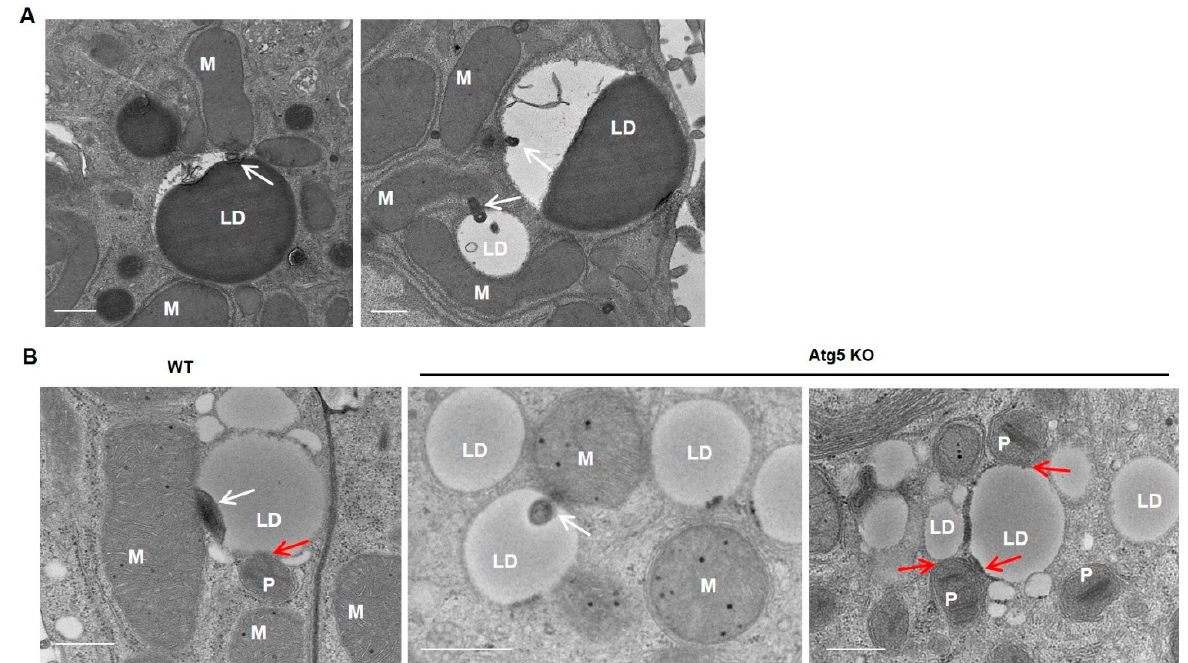
Figure 5. Dot- or tubular-like mitochondria–LD contact sites in starved or oleic-acid-treated primary mouse hepatocytes. Primary mouse hepatocytes were cultured in EBSS for 2 h followed by EM analysis. ( A ) Representative EM images from hepatocytes cultured in EBSS are shown. Hepatocytes isolated from liver-specific Atg5 knockout (KO) mice and the matched wild-type (WT) mice were treated with oleic acid (OA, 500 µM) for 6 h followed by EM analysis. ( B ) Representative EM images from OA-treated WT hepatocytes and Atg5 KO hepatocytes are shown. White arrows denote electron-dense dot- and tubular-like mitochondria–LD contact sites. Red arrows denote peroxisome–LD contact. LD: lipid droplet; M: mitochondria; P: peroxisome. Bar: 500 nm.